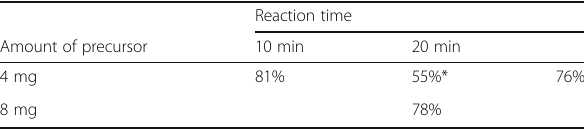
Table 1 (abstract PP38). Radiochemical yield of [ 18 F]MICA-304 Reaction